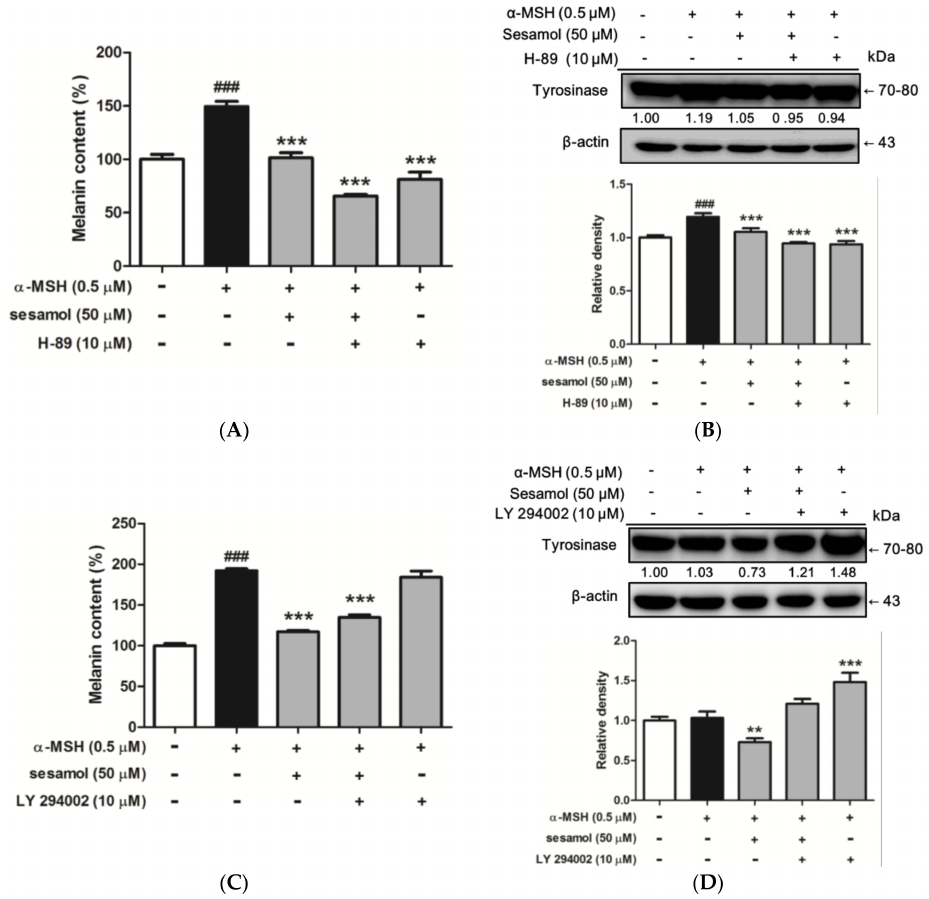
Figure 7. ( A ) Effect of sesamol and H-89 (PKA/MSK inhibitor) on melanin content (%) in α -MSH-treated B16F10 cells after 48 h. Each value is presented as the mean ± SD. ### p < 0.001 (Significant difference versus control); *** p < 0.001 (Significant difference versus α -MSH treated group). ( B ) Effects of sesamol and H-89 (PKA/MSK inhibitor) on protein expression of tyrosinase in α -MSH-treated B16F10 cells after 48 h. Each value is presented as the mean ± SD. ### p < 0.001 (Significant difference versus control); *** p < 0.001 (Significant difference versus α -MSH treated group). ( C ) Effects of sesamol and LY 294002 (PI3K inhibitor) on melanin content (%) in α -MSH-treated B16F10 cells after 48 h. Each value is presented as the mean ± SD. ### p < 0.001 (Significant difference versus control); *** p < 0.001 (Significant difference versus α -MSH treated group). ( D ) Effects of sesamol and LY 294002 (PI3K inhibitor) on protein expression of tyrosinase in α -MSH-treated B16F10 cells after 48 h. Each value is presented as the mean ± SD. ** p < 0.01, *** p < 0.001 (Significant difference versus α -MSH treated